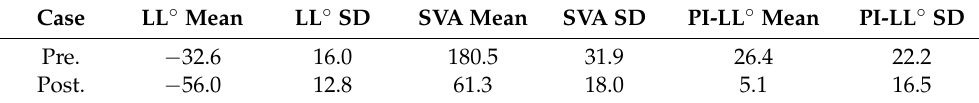
Table 2. ACR cases sagittal balance